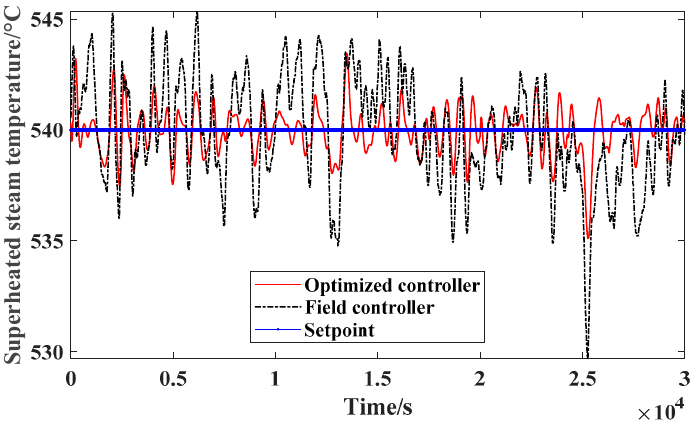
Figure 9. Control performance comparison.